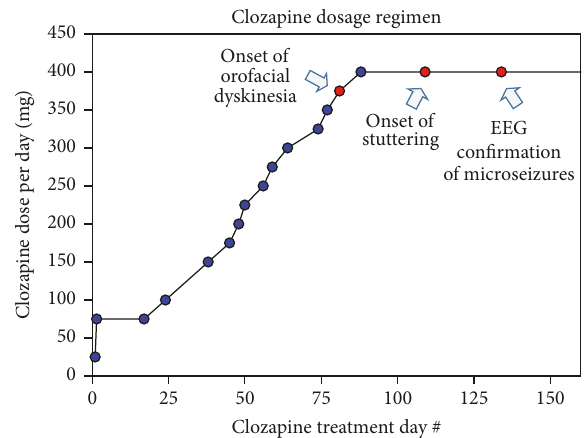
Figure 1: Dose escalation and key events in the course of the patient’s clozapine therapy. On Day 334 of clozapine therapy: dose = 400 mg per day, level = 541ng/ml (pharmacokinetic study results included in the clozapine package insert report peak concentrations of 102–771 ng/ml and minimum steady state concentrations of 41–343 ng/ml [11]). The patient was also on concurrent lithium 300 mg PO BID on Day 1 of clozapine therapy which was subse- quently increased to 450 mg PO BID on Day 24 of clozapine therapy. The patient did not demonstrate any symptoms of lithium